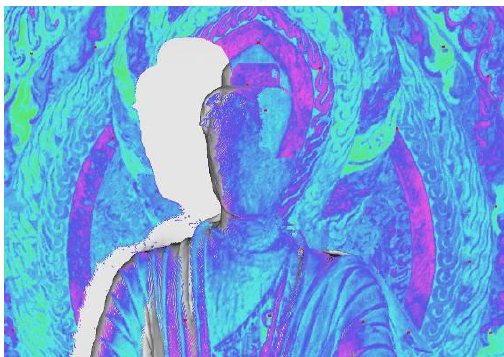
Figure 4 Overlapped display of intensity of point cloud and geometric model.